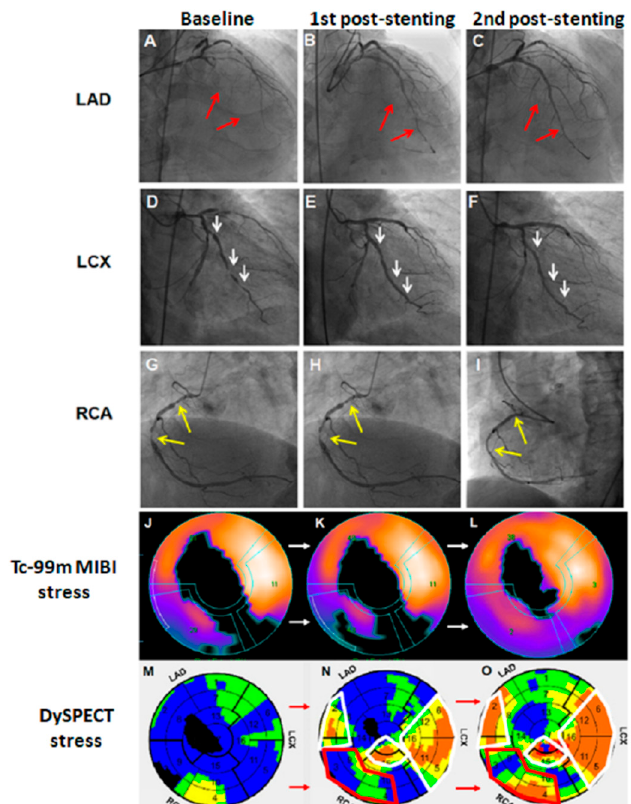
Figure 2. Due to the 63.76% extent of the ischemic myocardia seen on Dynamic SPECT/CT, he underwent PCI intervention, which revealed 80% stenosis over the left main (LM), total occlusion over LAD ( A , red arrows), 90% stenosis over the left circumflex artery (LCX) ( D , white arrows), and in-stent restenosis over the RCA ( G , yellow arrows). To rescue the jeopardized myocardium, stents were inserted over the LAD to the LM ( B , red arrows), LCX ( E , white arrows) but not over the RCA orifice ( H , yellow arrows). Two months later, Dynamic SPECT/CT was arranged again for post-PCI follow-up. The stress extent of MPI revealed similar defects ( J , K ) with a 2.41% decreased infarction area in the LAD territory and remarkably increased stress myocardial blood flow (MBF) on dynamic SPECT/CT ( M , N ; areas outlined in white). Secondary PCI was performed one month later, and stents were inserted over RCA territory ( I , yellow arrows). LAD and LCx territories showed no in-stent restenosis ( C,F ; red and white arrows. The following MPI demonstrated partial improvement in RCA and LCX territories, but a defect remained in the LAD territory ( L ). Dynamic SPECT/CT revealed improved flow in the RCA territory ( N , O , area outlined in red).